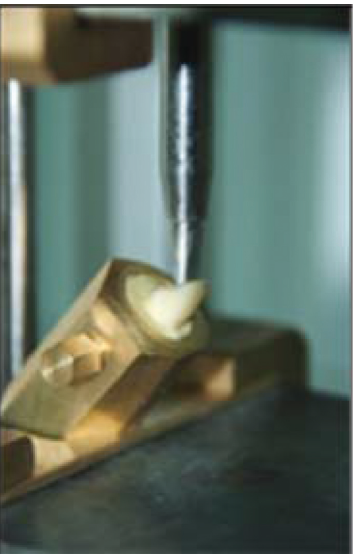
Figure 13: Loading stylus applying load onto the palatal surface of the crown 135 ° to the long axis of the tooth during the fracture resistance test.